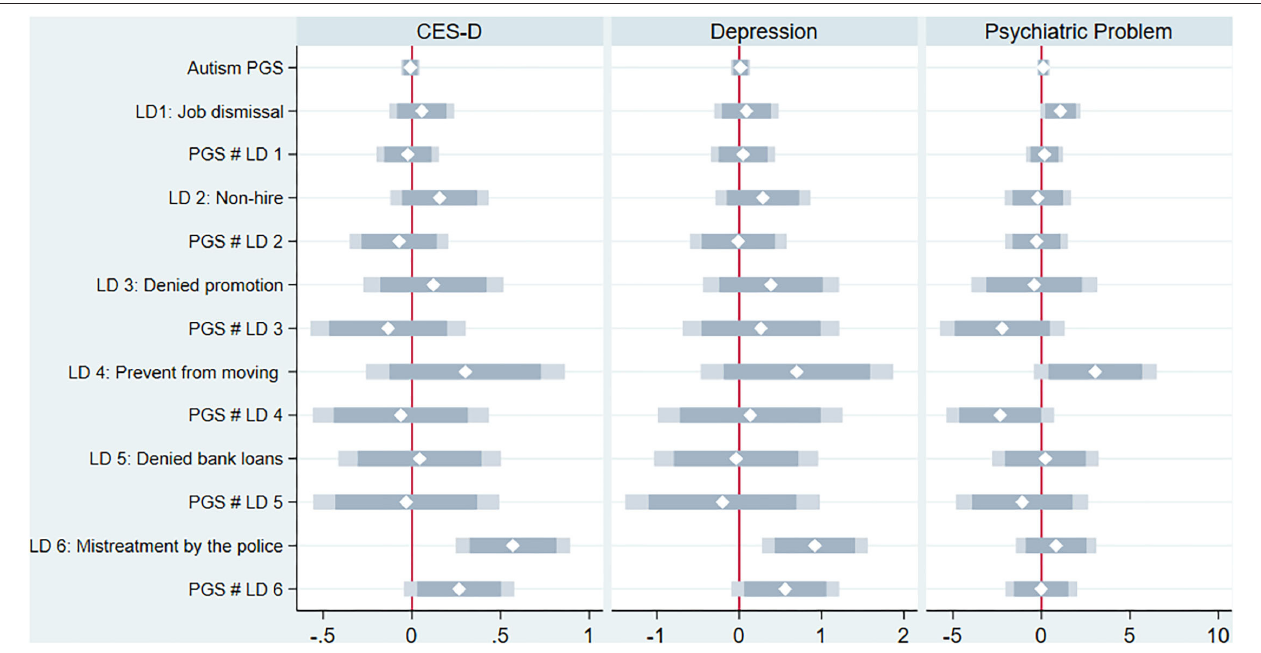
FIGURE 2 | Early life discrimination as a moderator for the relation between autism PGS and mental